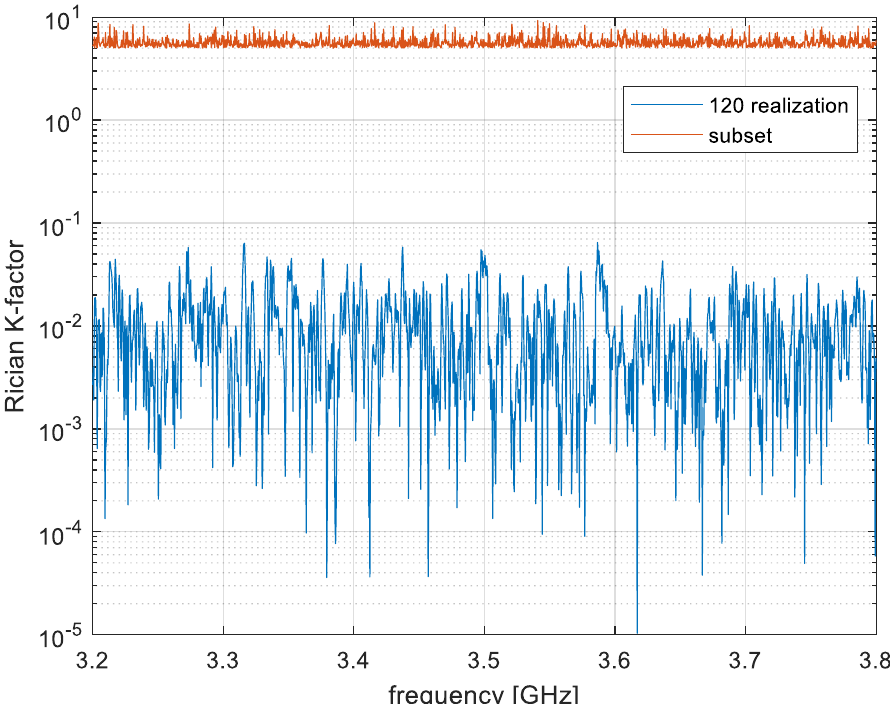
Figure 10. Rician K-factor frequency behavior with the 120 field configurations and after having applied the algorithm in the frequency band 3.27-3.80 GHz.